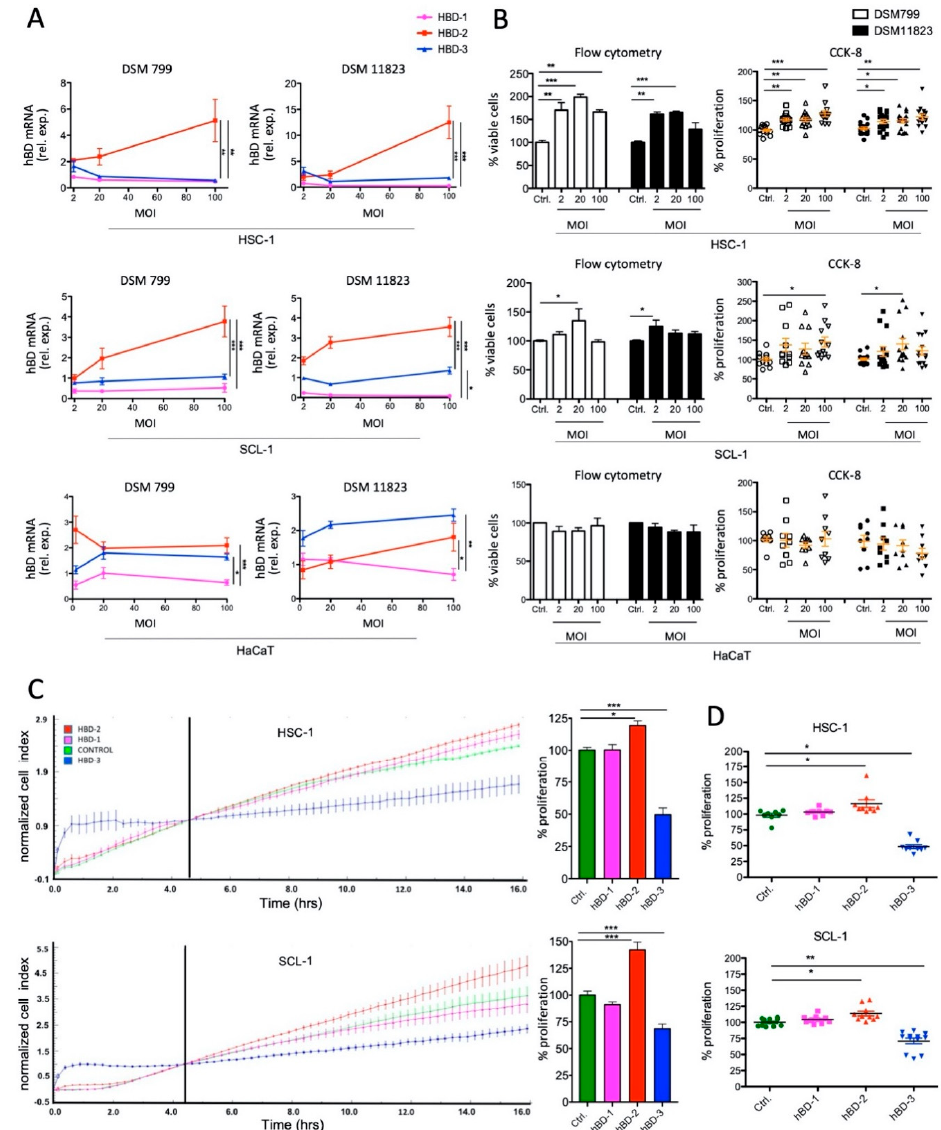
Figure 6. S. aureus challenge of cutaneous SCC cells stimulates hBD-2 expression and induces cell proliferation. ( A ) HSC-1, SCL-1, and HaCaT cells challenged with increasing MOIs of S. aureus DSM799 and DSM11823 show a dominant and dose-dependent increase of hBD2 mRNA expression in SCC cells measured by qPCR (* p < 0.05; ** p < 0.01; *** p < 0.005, one-way ANOVA, Bonferroni correction). ( B ) Significantly increased viable SCC cell numbers due to S. aureus challenge as compared to controls assessed by flow-cytometry (* p < 0.05; ** p < 0.01; *** p < 0.005, one-way ANOVA; Dunnett’s multiple comparison test) and the CCK-8 assay (* p < 0.05; ** p < 0.01; *** p < 0.005, Kruskal–Wallis, Dunn’s multiple comparison test). HaCaT cells show no increase in cell numbers. ( C ) Real-time monitoring of HSC-1 (top) and SCL-1 (bottom) cell growth with the xCelligence TM system during challenge with 20 µ g / mL of hBD-1, -2 and -3, respectively. An increased cell proliferation due to hBD-2 challenge and a decreased proliferation due to hBD-3 challenge was detected after 16 h (measure: normalized cell index; representative graph of three repetitions). Bar charts on the right indicate relative (%) cell proliferation compared to controls at 16 h (* p < 0.05; *** p < 0.005, one-way ANOVA, Turkey’s multiple comparison test). ( D ) hBD-2 increases and hBD-3 decreases proliferation of HSC-1 (top) and SCL-1 (bottom) cells treated with 20 µ g / mL AMPs for 24 h measured by the CCK-8 assay (* p < 0.05; ** p < 0.01, Kruskal–Wallis, Dunn’s multiple comparison